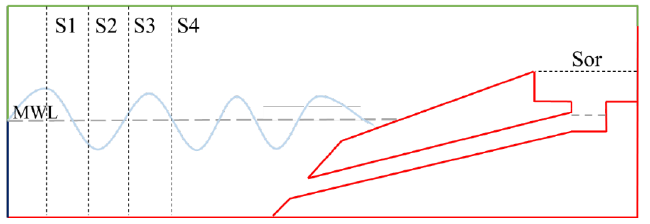
Figure 7. Illustration of the position of gauges S1, S2, S3 S4 and Sor.